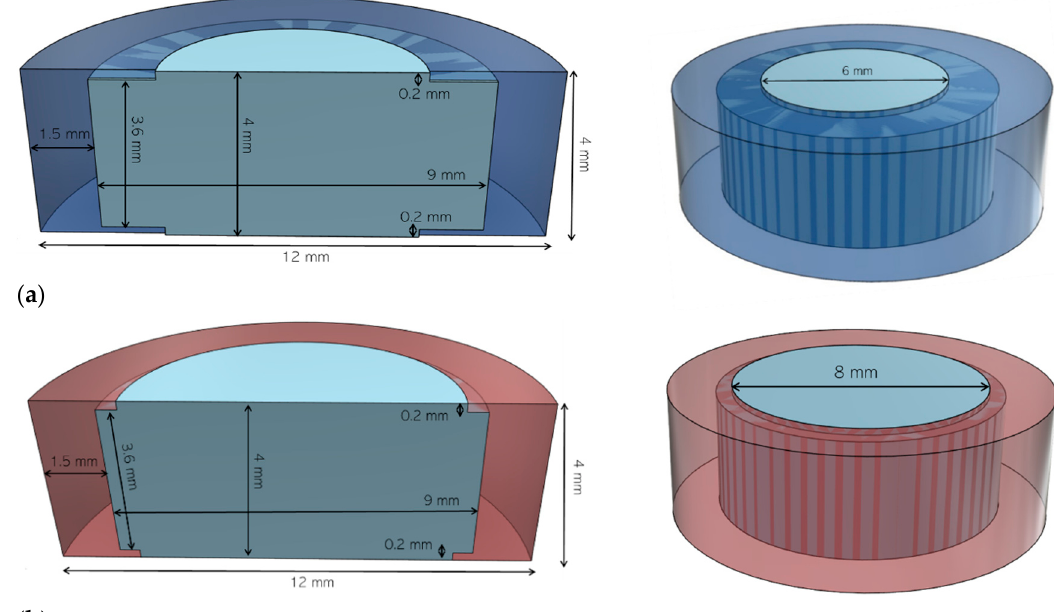
Figure 1. ( a ) Vertical cross section (left) and top view (right) of the 6 mm printlet 3D model; ( b ) vertical cross section (left) and top view (right) of the 8 mm printlet 3D model.